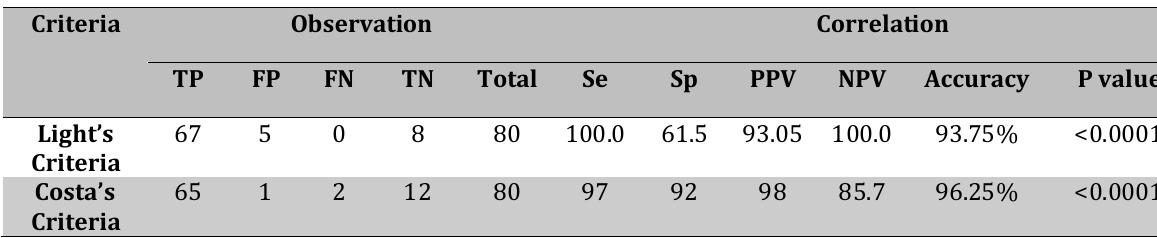
Table 5. Light’s criteria and costa’s criteria sensitivity (SE), positive predictive value (PPV), specificity (SP), negative predictive value(NPV)